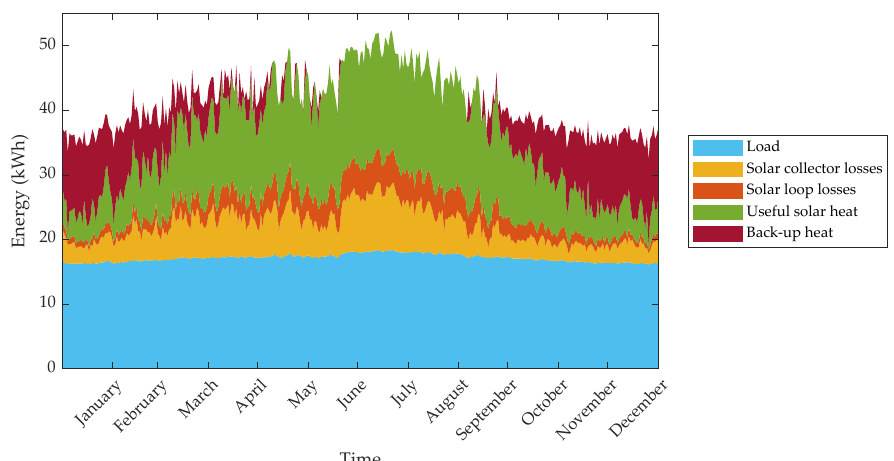
Figure 8. Annual distribution of energies (simulation according to